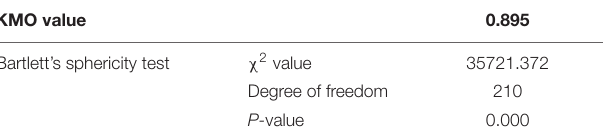
TABLE 2 | Validity result analysis. KMO value